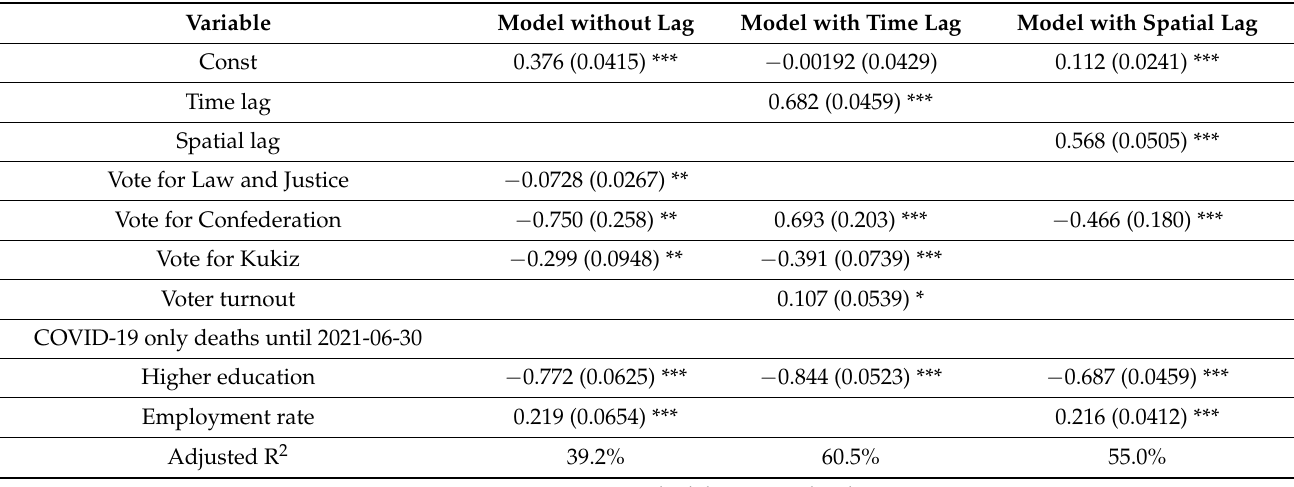
Table 3. Percentage of remaining population in age group 60–69 that were vaccinated against COVID-19 between 30 June 2021 and 31 January 2022.